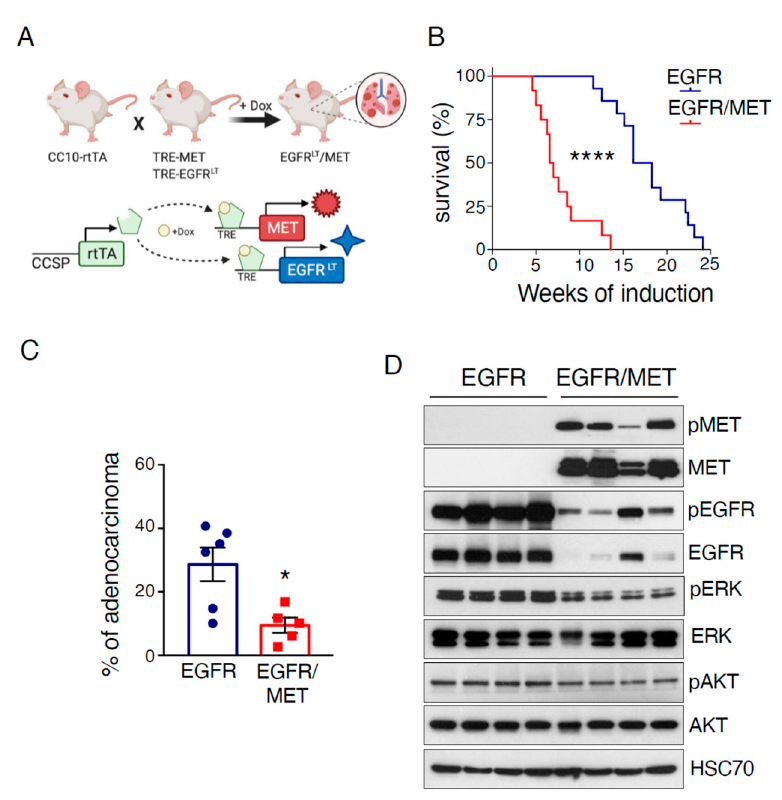
Figure 1. MET overexpression decreases survival of mice harboring EGFR-driven lung adenocarcinoma. ( A ) Cartoon depicting the strategy to generate EGFR/MET mice (top) and to activate the lung-specific expression of the two transgenes upon exposure to doxycycline diet (bottom). ( B ) Kaplan–Meier plot showing the survival rate of EGFR ( n = 14) and EGFR/MET ( n = 12) mice after doxycycline induction; **** p ≤ 0.0001 (Mantel–Cox test). ( C ) Percentage of adenocarcinomas vs. adenomas in each genotype. Values correspond to the mean ± SEM; * p ≤ 0.05 (unpaired t -test). EGFR ( n = 6) and EGFR/MET ( n = 5). ( D ) Immunoblotting of the indicated proteins in lung tumors from EGFR and EGFR/MET